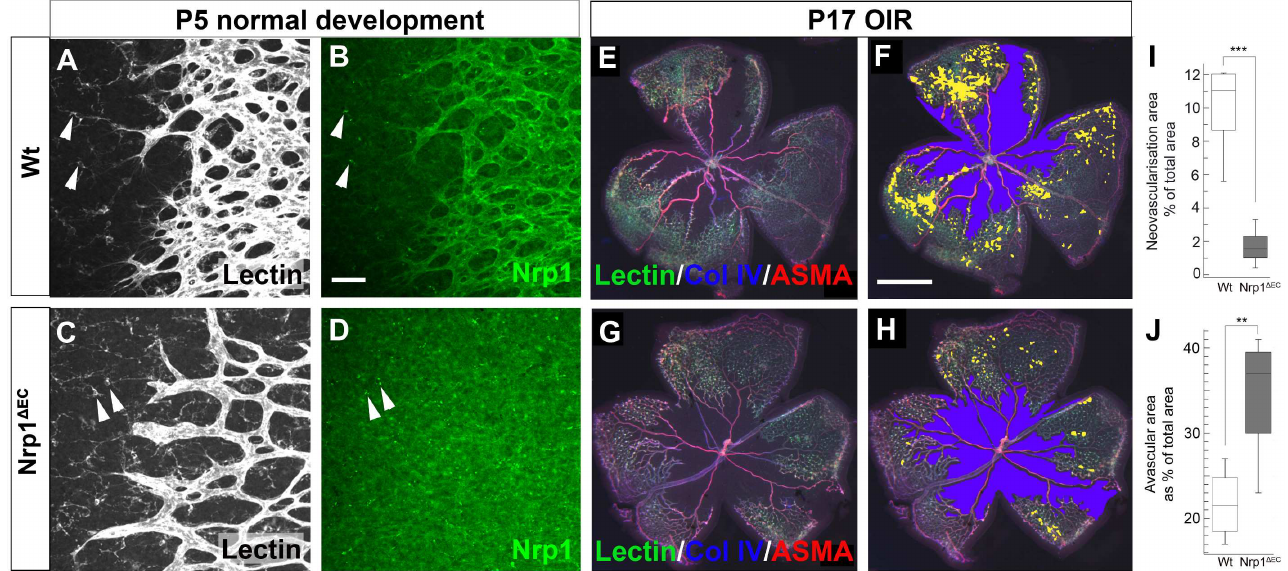
Fig 4. Loss of endothelial Nrp1 leads to reduced neovascularisation in the OIR model. Endothelial specific depletionof Nrp1 in the P5 retinal vasculature(OHT at P3) was confirmed by Nrp1 immunohistochemistry (A-D) on retinal wholemounts, visualisingNrp1 (green in B, D) and lectin staining(white in A, C). Nrp1 expressedby microglia(arrowheadsin A-D) was not affected. Effects on OIR were assessedat P17 (OHT at P11) by immunohistochemistry on retinal wholemounts (E, G), showinglectin staining (green), collagenIV (blue) and alpha smooth muscle actin (red). Quantification of neovascularisation (paintedyellow in F, H) and avascularareas (painted blue in F, H) showedreducedneovascularisation (I, p < 0.001)and increasedavascularareas (J, p = 0.01) in Nrp1 Δ EC animalscomparedto wild type animals(n = 6 Wt, n = 10 Nrp1 Δ EC ). Scale bars in B are 50 μ m and in F 1000 μ